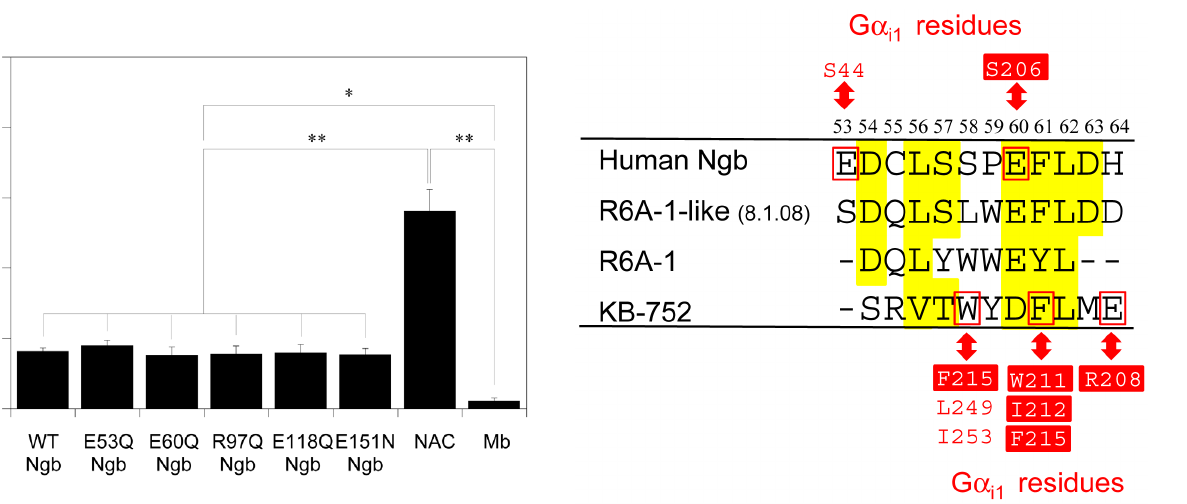
Figure 6. Multiple partial sequence alignment of human Ngb, R6A-1 peptide, R6A-1-like peptide (8.1.08) and KB-752 pep- tide. Homologous residues based on the sequence alignment among human Ngb and some peptides containing core motif for G a binding are highlighted in yellow. Numbers above the sequences correspond to those of the residues of human Ngb. Gaps in the sequences are indicated by dashes. Binding sites in human Ngb and G a i1 identified by MS analyses combined with chemical cross-linking of the proteins are listed: Glu53 and Glu60 of human Ngb are cross-linked to Ser44 and Ser206 of G a i1 , respectively [23]. The specific G a i1 amino acid residues that interact with amino acid residues in KB-752 peptide (Trp5, Phe8, and Glu11) are listed based on the structure of the KB-752 peptide bound to G a i1 [41]. Residues in the switch II (a.a. 199–219) of G a i1 were highlighted in red